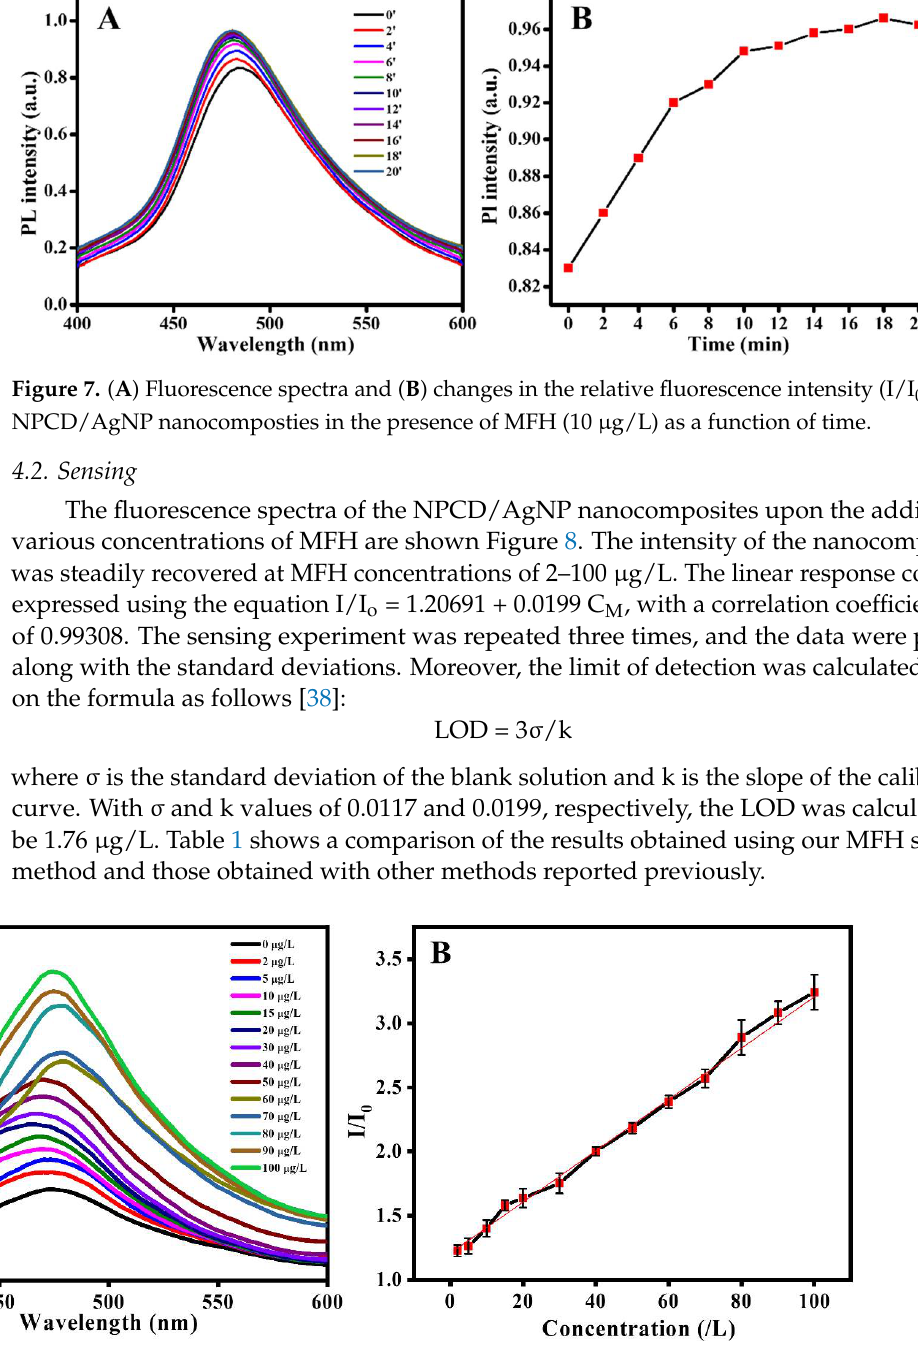
Figure 8. ( A ) Fluorescence response and ( B ) relative fluorescence results for the NPCD/AgNP nanocomposites in the presence of various concentrations of MFH. Table 1. Results of MFH detection using our method and previously reported methods.